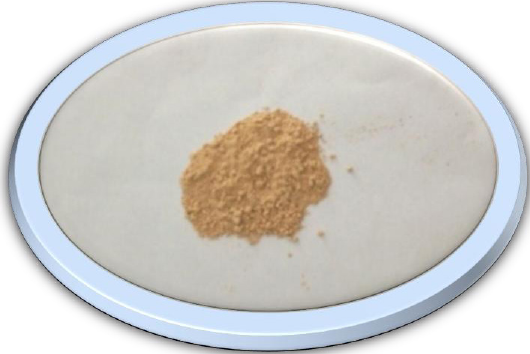
Figure 1: Zingiber officinale root powder (synthesised from Zinger